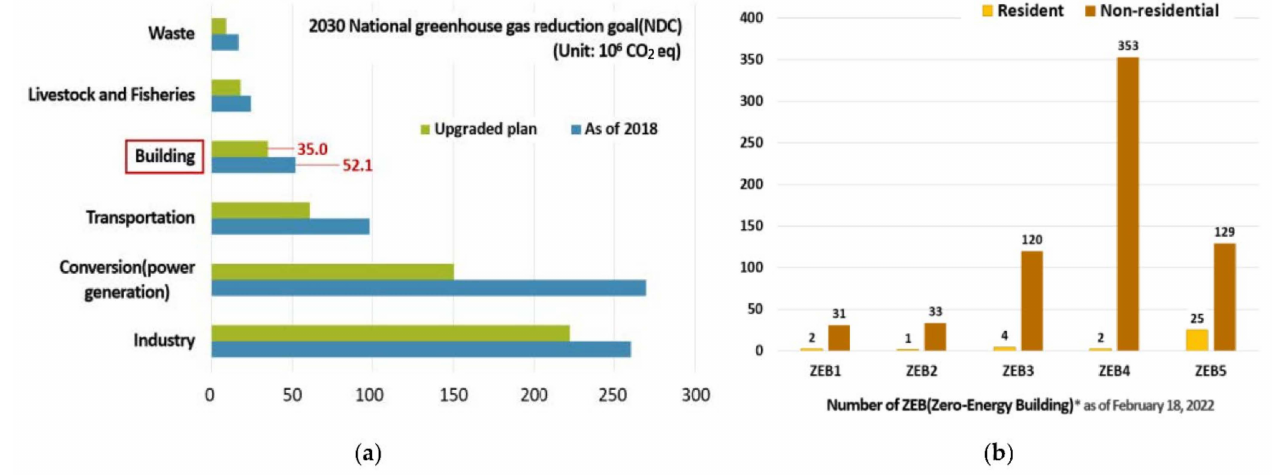
Figure 1. ( a ) 2030 national greenhouse gas reduction goals (NDC) [3]; ( b ) Number of buildings certified as preliminary zero-energy buildings (ZEBs)